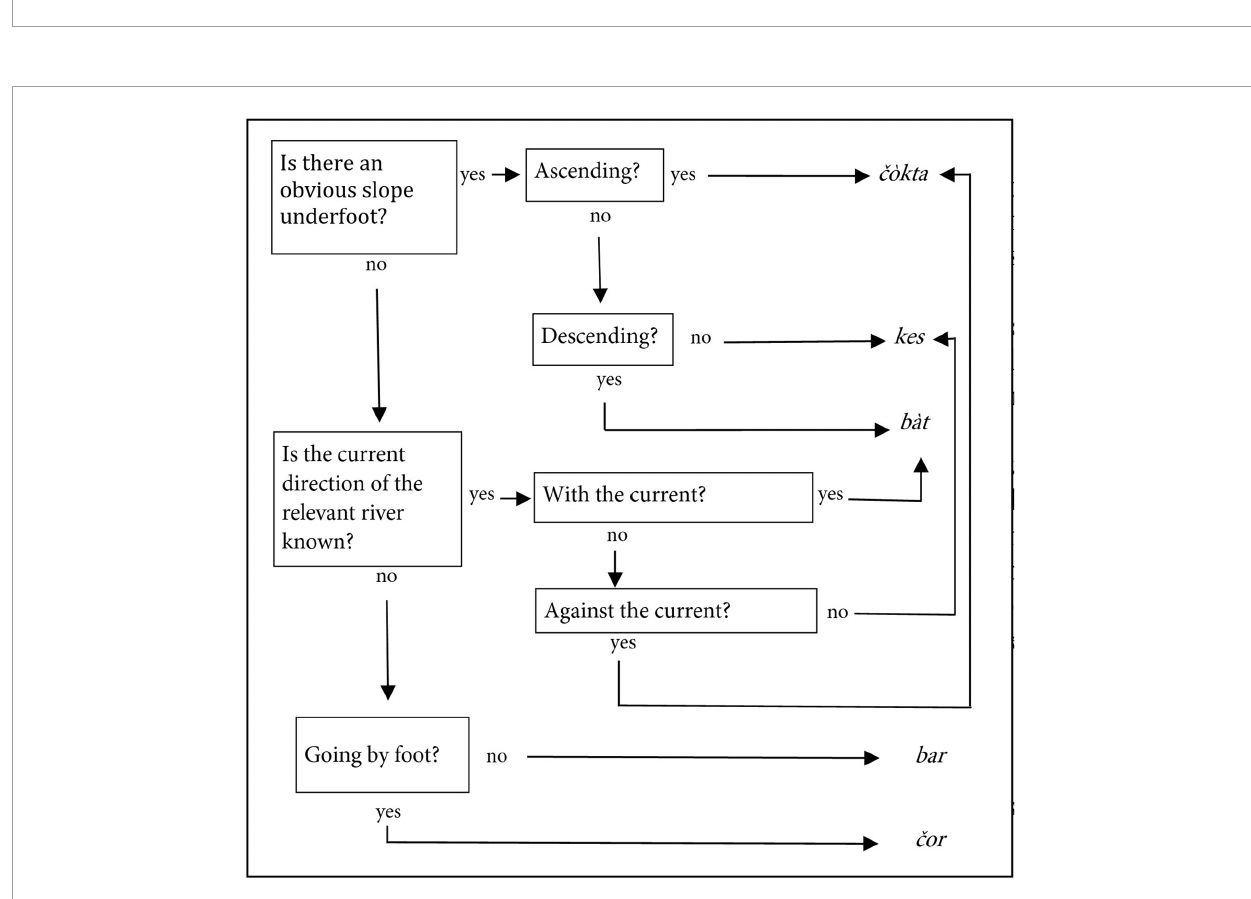
FIGURE4 Flowchart for Tuvan verbs of motion in topographic orientation, redrawn from Harrison (2007: